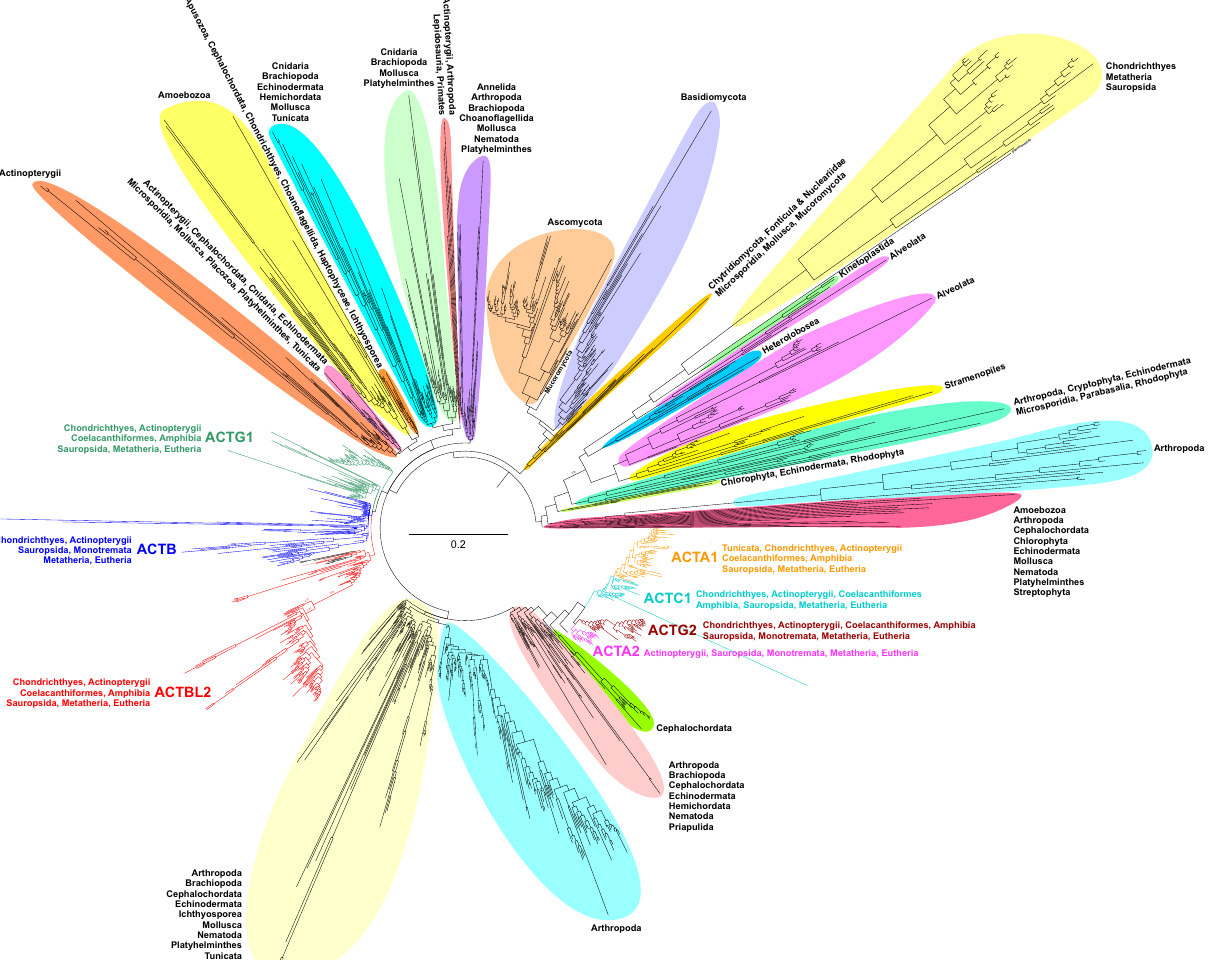
Figure 1. Phylogram obtained in MrBayes showing relationships between 1441 amino acid sequences of actins and their relatives. Seven groups of actins similar to human sequences: ACTB , ACTG1 , ACTA2 , ACTA1 , ACTC1 , ACTG2 , and ACTBL2 are indicated in different colors. Affiliation to major taxonomic groups is also shown for main